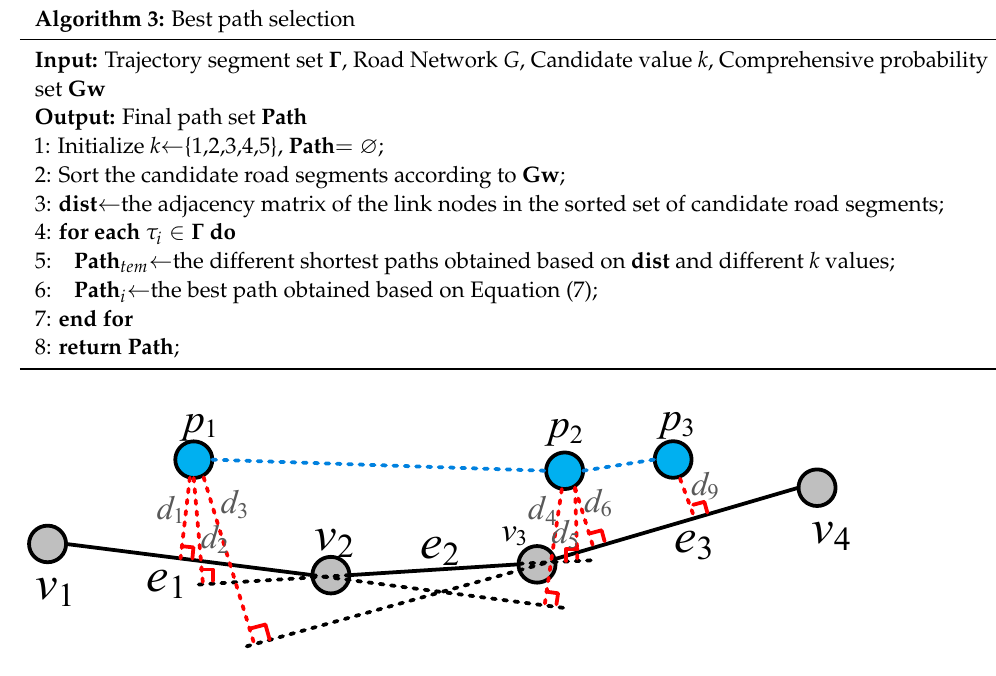
Figure 9. Find the best matching path. Algorithm 3: Best path selection